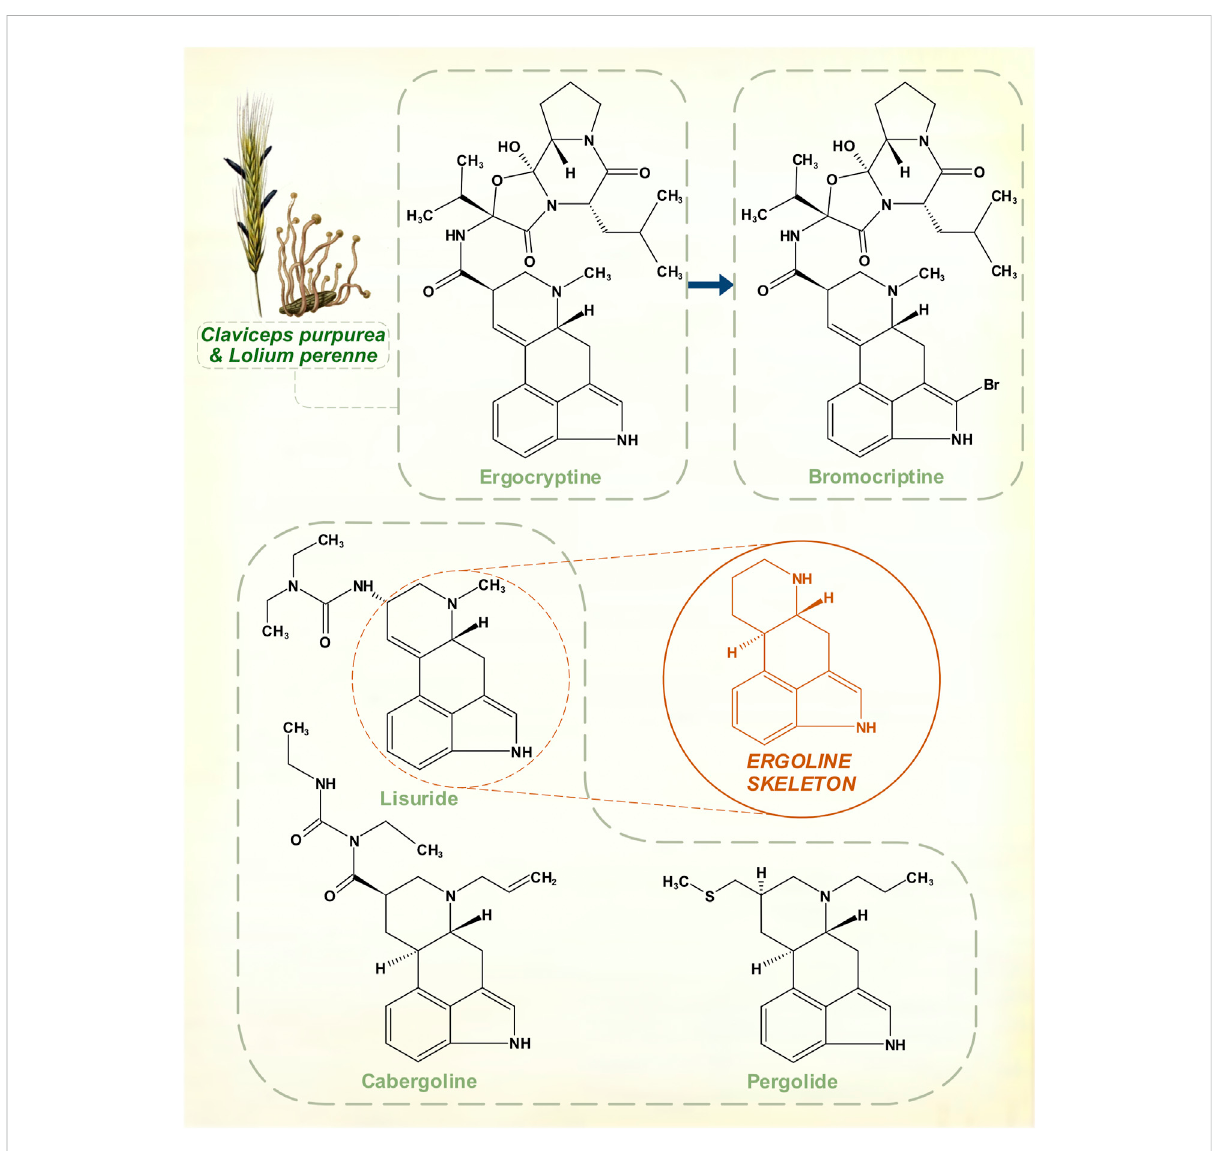
The amino acid L-tryptophan is a precursor for the ergoline skeleton, present in over 70 ergot alkaloids isolated from Claviceps fungal species. Naturally occurring ergocryptine and its pharmaceutical modi fi cation to create bromocriptine. Other synthetic ergoline dopamine receptor agonists:cabergoline,lisurideandpergolide.Topleft:Ergotsclerotiaonperennialryegrass.[IllustrationsadaptedfromEsser(1910)andKöhler(1897), both available in the public